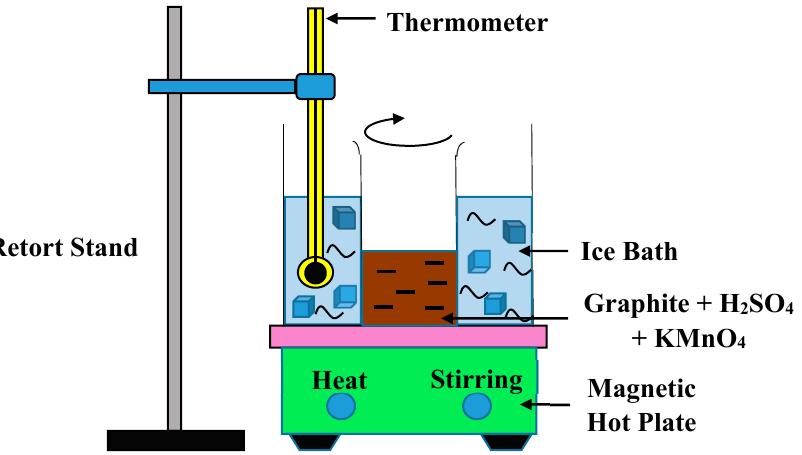
Figure 1: Experimental setup of simplified Hummer’s method Figure 1. Experimental setup of simplified Hummer’s method. Figure 1. Experimental setup of simplified Hummer’s method